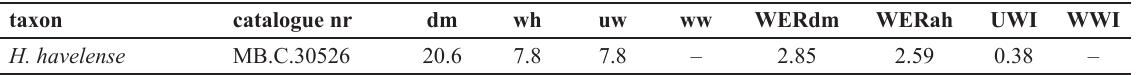
Table 8. Conch measurements (in mm), ratios and rates of coiled conch parts of Holmiceras Hyatt,